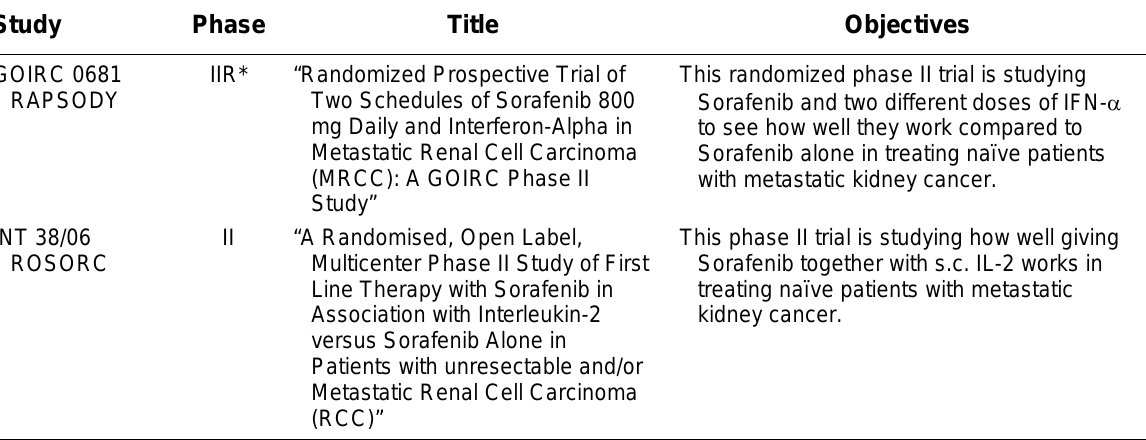
Ongoing Italian Combination Trials of Immunotherapy and Molecularly Targeted Drugs in Advanced RCC